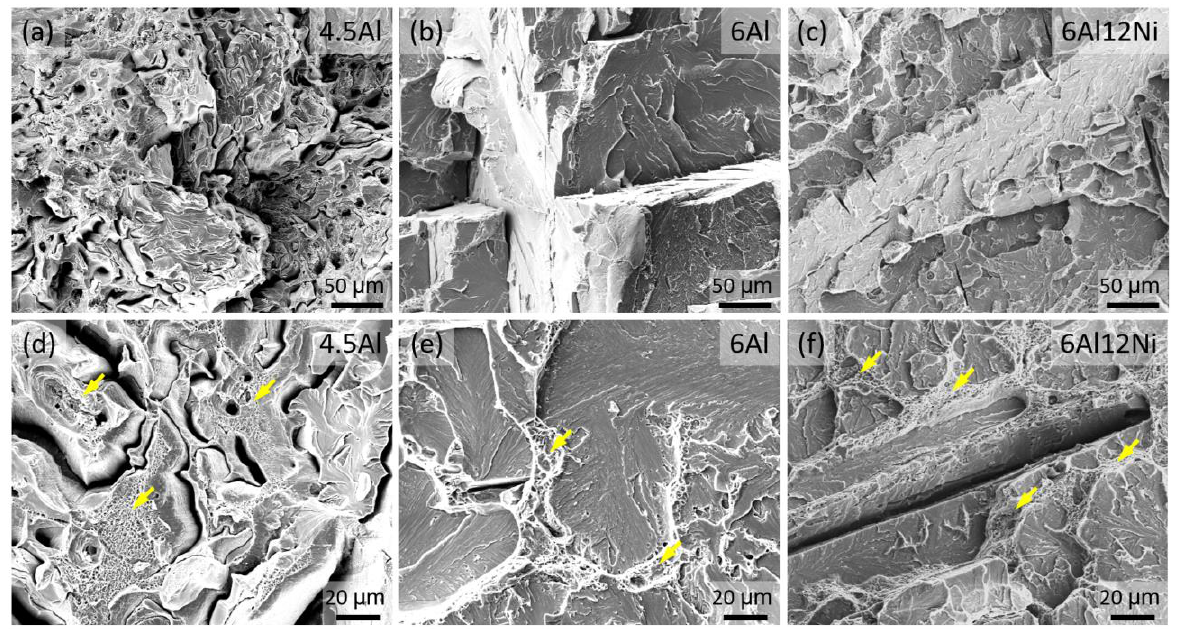
Figure 13. Fracture surface of ( a , d ) 4.5Al steel, ( b , e ) 6Al steel and ( c , f ) 6Al12Ni steel. Arrows in ( d – f ) indicate regions exhibiting dimple formation.